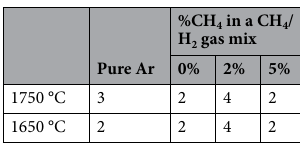
Table 1. The experimental matrix, the number in each cell indicates the number of